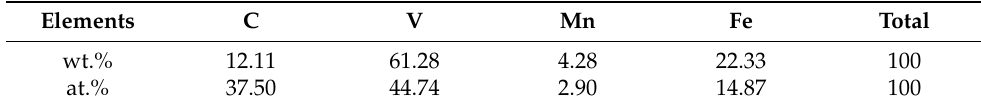
Figure 3. Transmission electron microscopy (TEM) micrograph showing the distribution of carbides aged at different tem- peratures: ( a ) 450 °C, ( b ) 550 °C, ( c ) 650 °C, ( d ) 750 °C, ( e ) X-ray energy-dispersion spectra (EDS) of the carbides. Table 1. The chemical composition of the vanadium carbides. Table 1. The chemical composition of the vanadium carbides. Elements